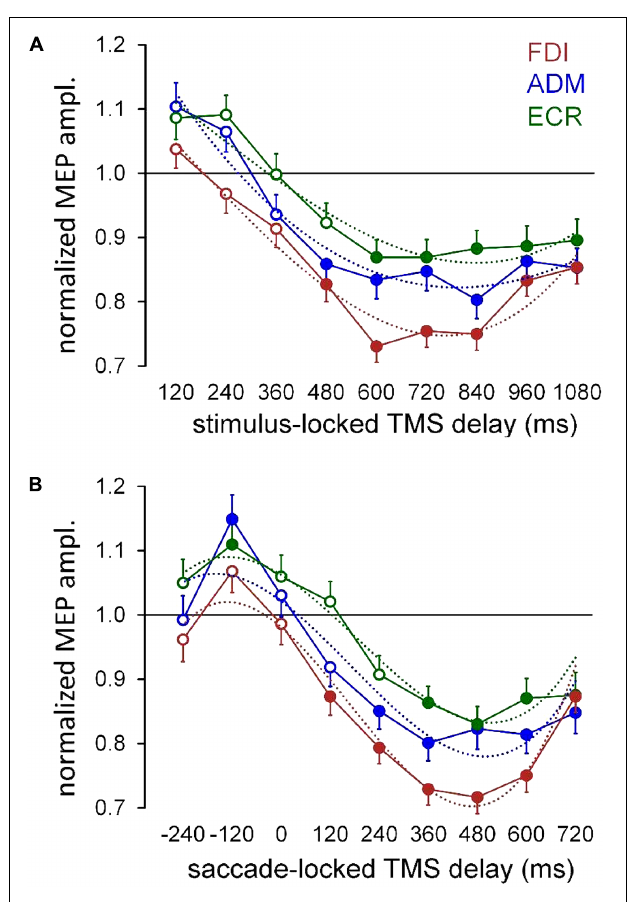
FIGURE 3 | Mean MEP amplitudes across subjects irrespective of ocular task condition and gaze direction. (A) Mean values were computed for each muscle as a function of TMS delay with respect of the onset of the peripheral visual stimulus (‘stimulus-locked TMS delay’). (B) Mean values were obtained by grouping the TMS delays with respect to the beginning of the ocular response, in equally spaced bins of 120 ms (‘saccade-locked TMS delay’). Figures drawn along the X -axis represent the bin central values used for the averaging procedure. Filled symbols denote a statistically significant difference ( p < 0.05) from the baseline (see text). Values higher than unity indicate MEP amplitudes larger than baseline. Error bars represent the standard error of the mean. In both graphs, thin dotted curves depict the least-squares best fitting of the experimental data with a cubic polynomial.